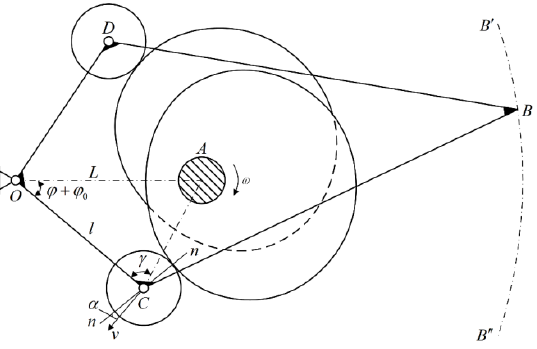
Figure 1. Schematic diagram of the proposed double-cam mechanism.